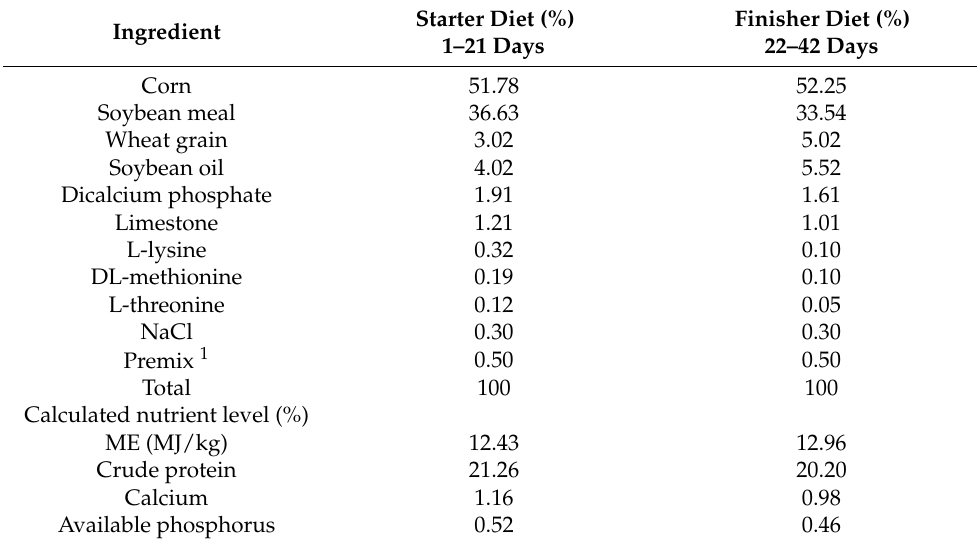
Table 1. Ingredients and composition of the standard diets for